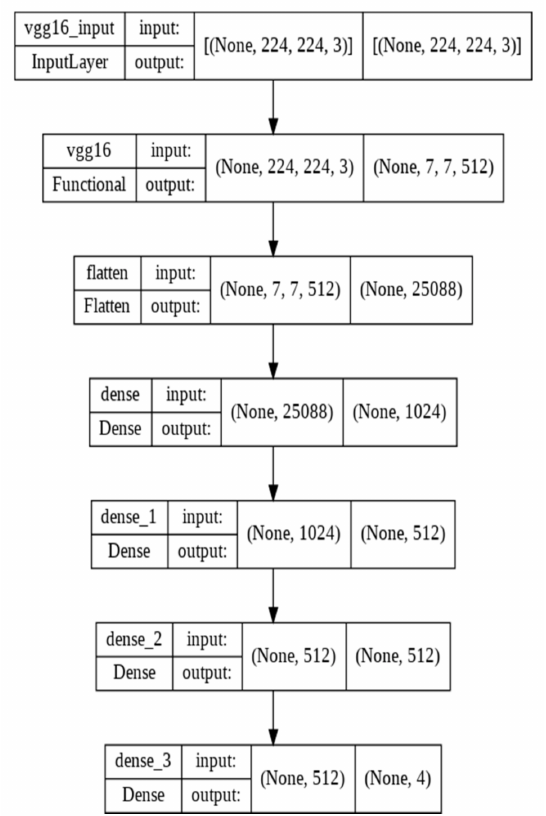
Figure 4. VGG16 architecture for